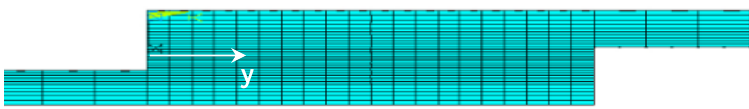
y Figure 6. Discretization of nodes and elements for Figure 6. Discretization of nodes and elements for simulation.